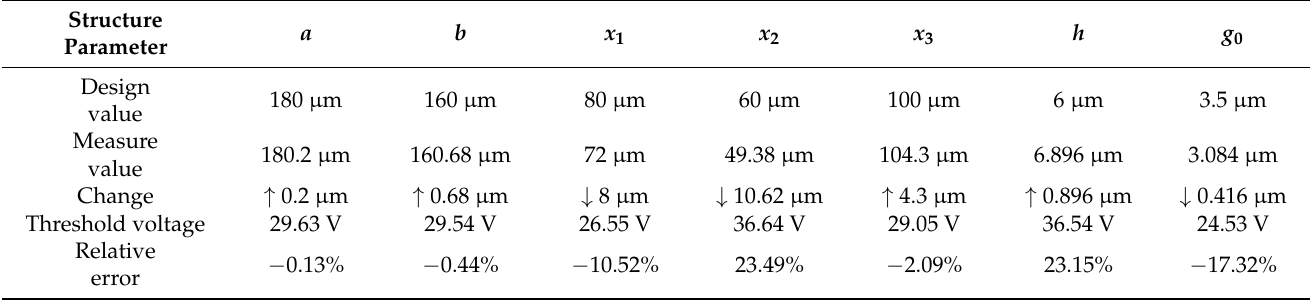
Table 4. Variation of threshold voltage.